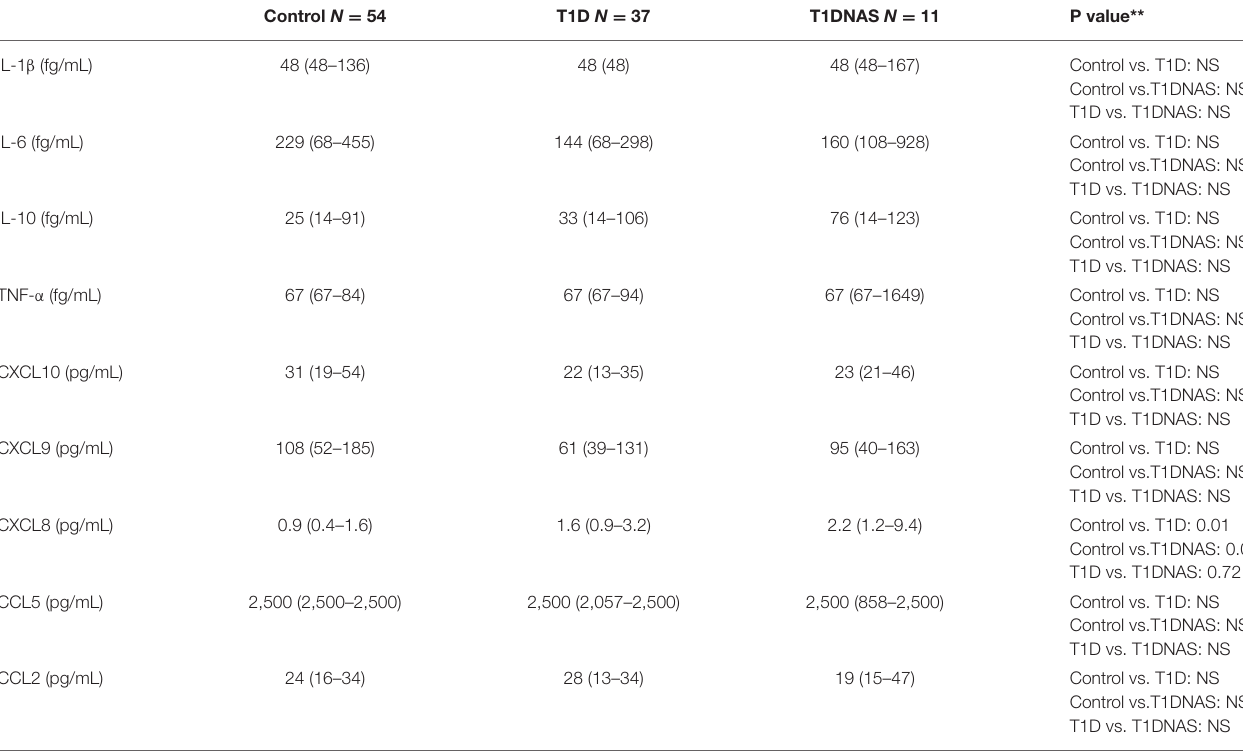
TABLE 3 | Serum concentration of cytokines and chemokine in control subjects, type 1 diabetes (T1D) patients from multiplex families and their non-affected siblings (T1DNAS). Control N =